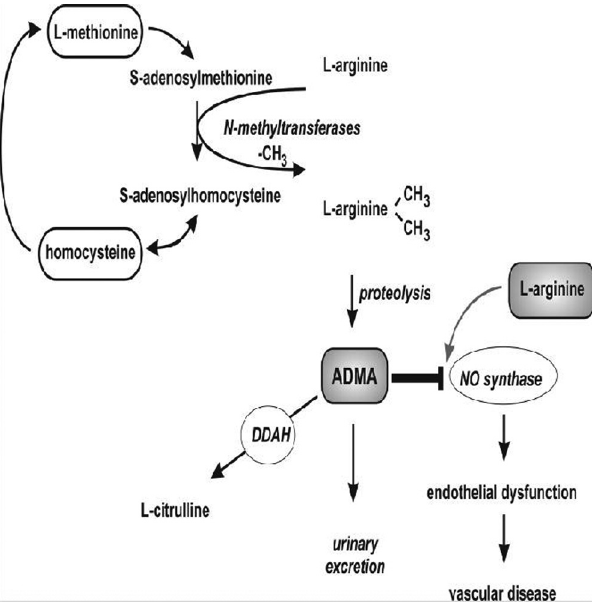
Figure 2 - Schematic view of the biochemical pathways related to ADMA. Modified from Böger RH. Asymmetrical dimethylarginine (ADMA): a novel risk marker in cardiovascular medicine and beyond. Annals of Medicine.